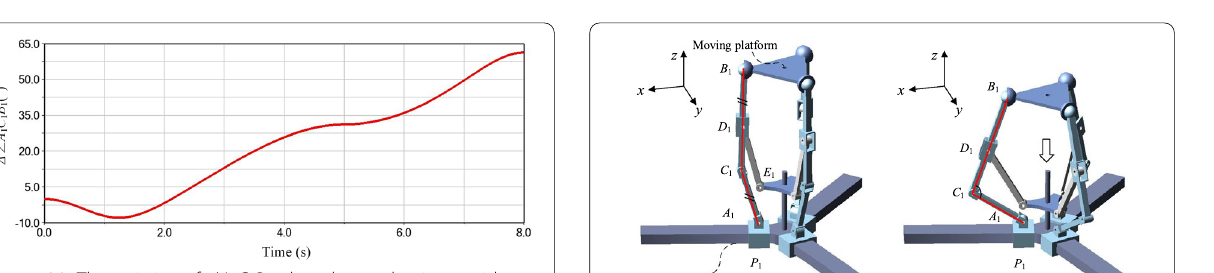
Figure 22 The variation of ∠ A 1 C 1 B 1 when the mechanism avoids singular position 1 (The symbol “ (cid:31) ” represents the variation of the angle)